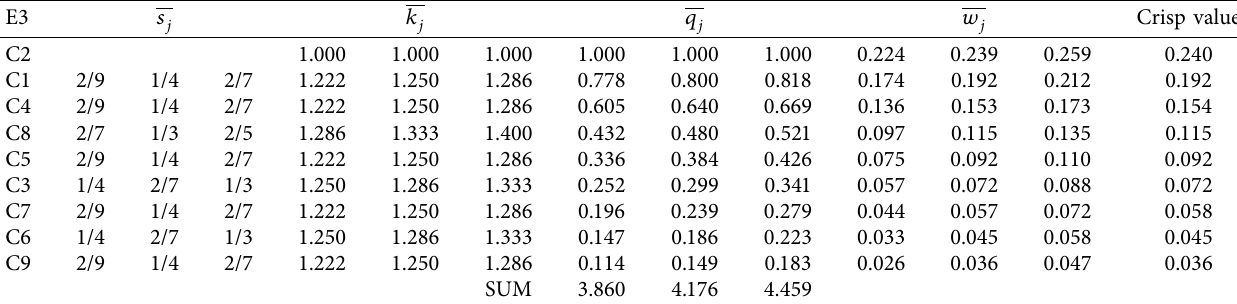
Table 5: Calculation and values of weight coefficients obtained by the IMF SWARA method for E3.